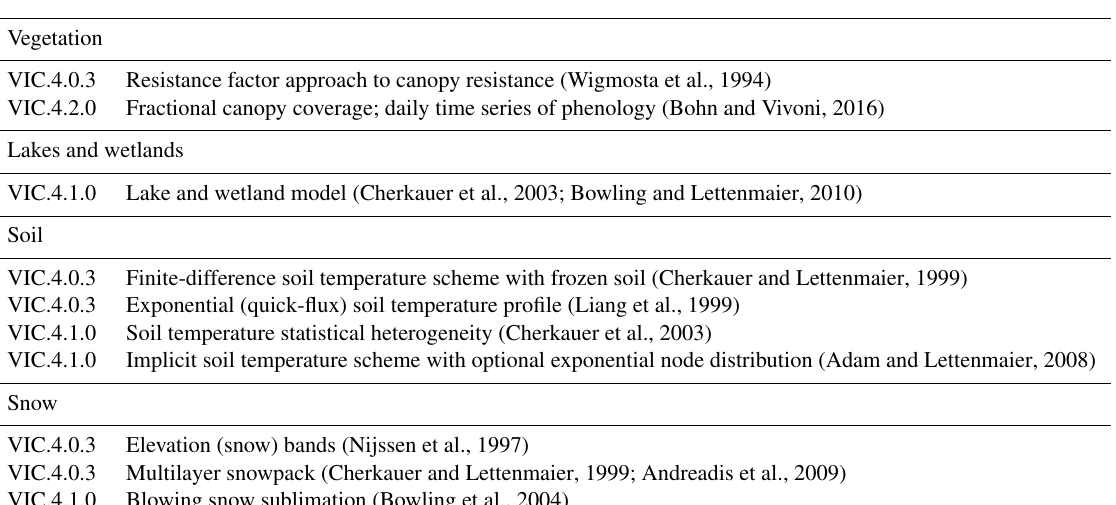
Table A1. Summary of major VIC developments present in VIC-5, focusing on improved process representations, and the model versions that were added since the original publication of Liang et al.